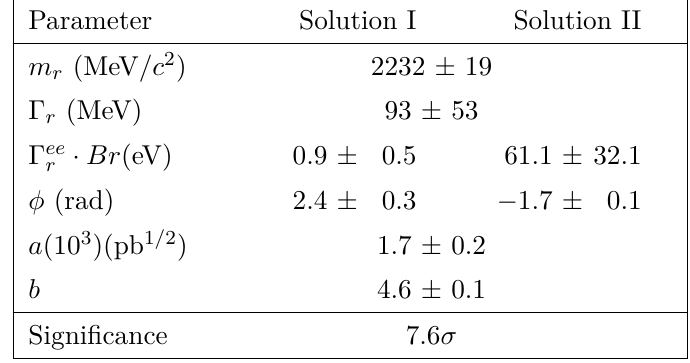
Table 9 . Resonance parameters obtained in the fit to the e + e − → ωππ cross section. The uncer- tainties are statistical